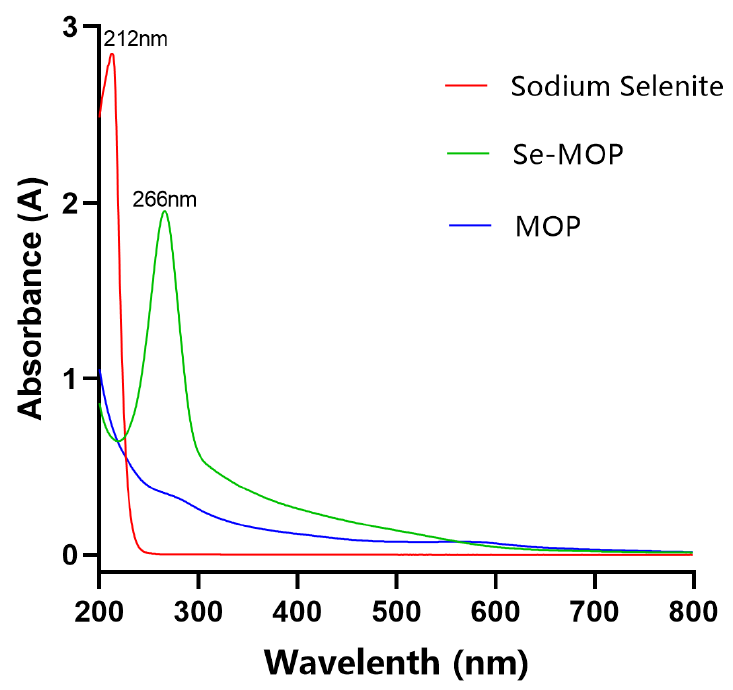
Figure 2. UV spectra of Se-MOP (green line), sodium selenite (red line), and MOP (blue line) in the range of 200–800 nm. The horizontal coordinate represents the wavelength (nm). The vertical coordinate represents the absorbance. The Se-MOP line peaks at 266 nm. The sodium selenite peaks at 212 nm. The MOP line does not peak.